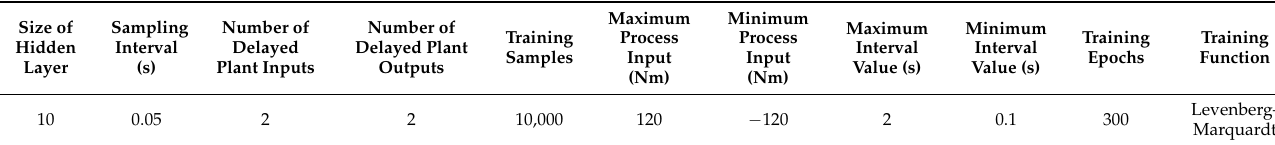
Table 6. The parameters of neural model identification.